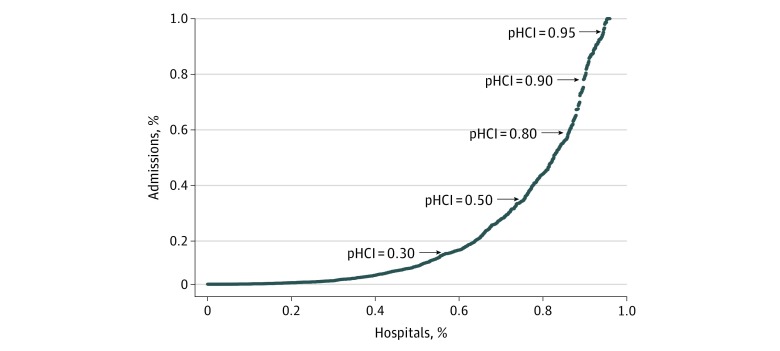
Cumulative Percentage of Pediatric Hospital Admissions for Abdominal Pain and AppendicitisThe percentages are ordered according to pediatric Hospital Capability Index (pHCI), which varies between 0 (low pediatric capability on average) and 1 (high pediatric capability on average). Discontinuities in the curve reflect the fact that some hospitals admit a significant proportion of pediatric patients.